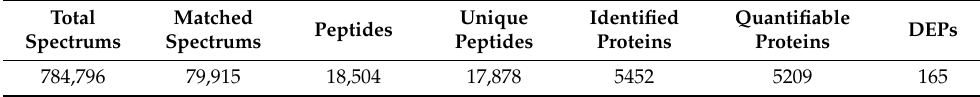
Table 1. Summary of TMT-Based LC-MS/MS analysis.